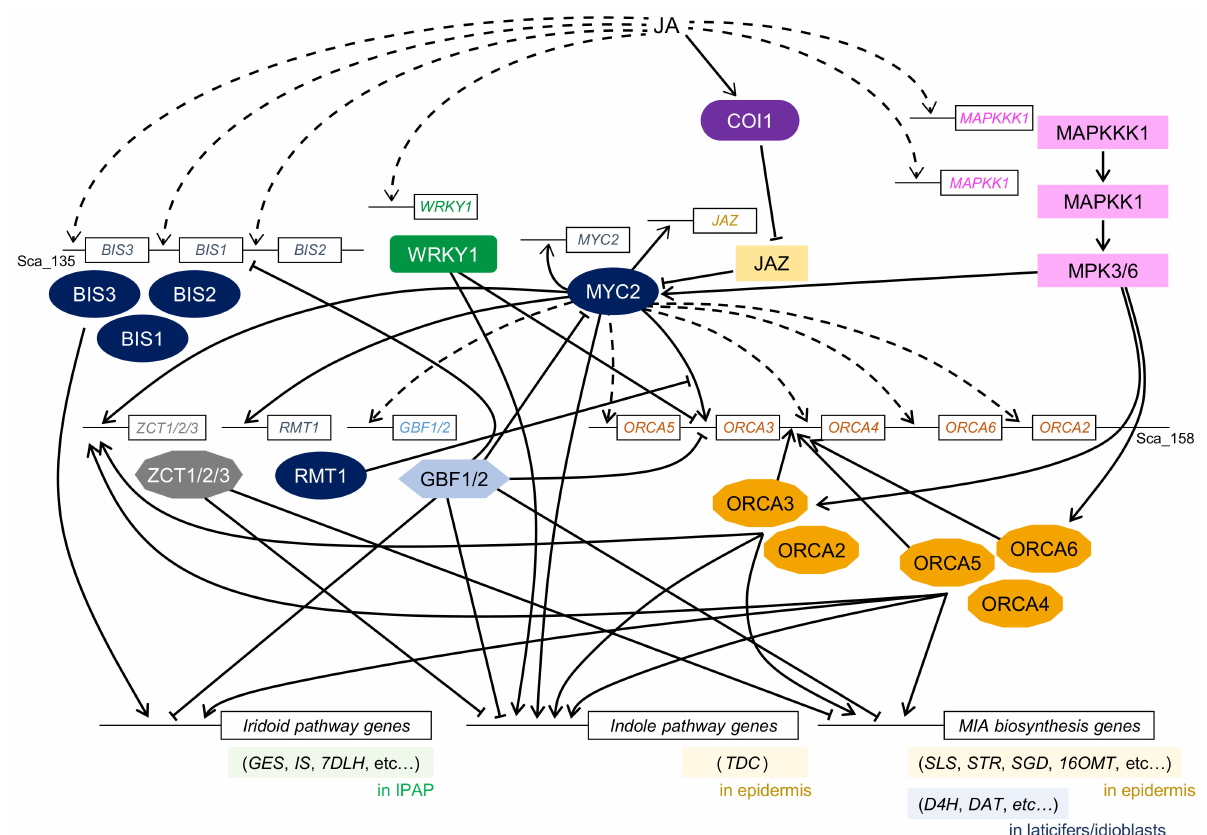
Figure 3. A simplified model of the transcriptional network of JA signaling involved in MIA biosynthesis in C. roseus . Boxes with straight lines indicate regulator genes, including promoter regions. Black arrows indicate upregulation, and T-shaped lines indicate inhibition. Broken lines show indirect or undetermined steps possibly involved in uncharacterized proteins or unidentified regulation. GES, IS, and 7DLH marked in the green box work in the iridoid pathway to synthesize loganic acid in internal phloem-associated parenchyma (IPAP), while D4H and DAT marked in the blue box function in the biosynthesis of vindoline in laticifers/idioblasts. The relationship between tissue/cell-specific regulation of enzyme genes and JA-responsive TFs remains unknown. Secologanin, tryptamine, strictosidine, tabersonine, and desacetoxyvindoline are synthesized in the upper or lower epidermis by SLS, STR, SGD, 16OMT, and TDC marked in the yellow boxes. Possible feedback regulation via MYC2 TF, which is known to regulate the expression of its own and JAZ genes, is shown. It is still unknown whether the expression of other genes such as BIS , WRKY1 , and MAPKKK1 is directly regulated by MYC2. BIS and ORCA genes are clustered in the same C. roseus genome scaffolds, scaffold_135 and scaffold_158,